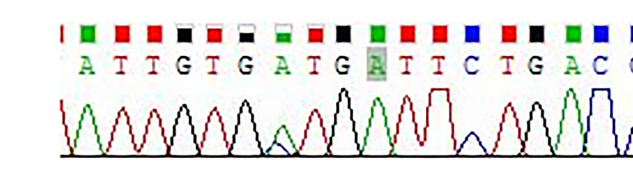
FIGURE 4 c-kit mutation at exon. Kit 10: 1621A>C (Met541Leu) missense mutation.